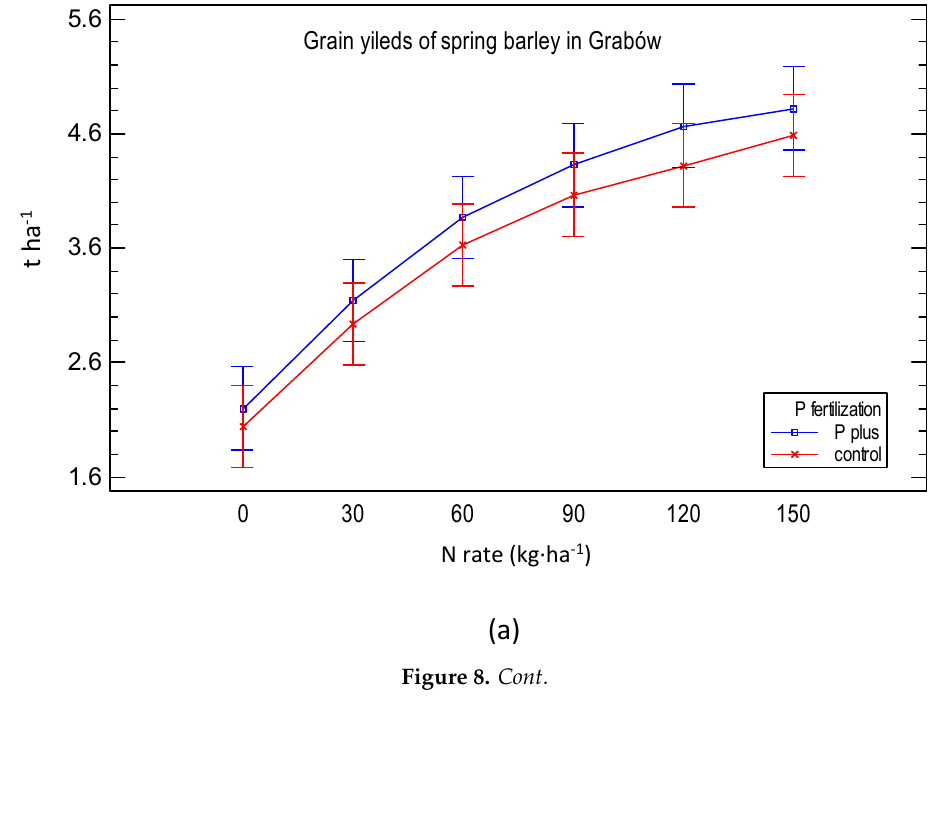
Figure 7. Grain yields of maize at increasing additions of N fertilizer at the P-plus and control levels of P; 95% Tukey HSD intervals; n = 384 for each location (P fertilization (a) Grabów HSD 1.183, (b) Baborówko HSD 0.894).